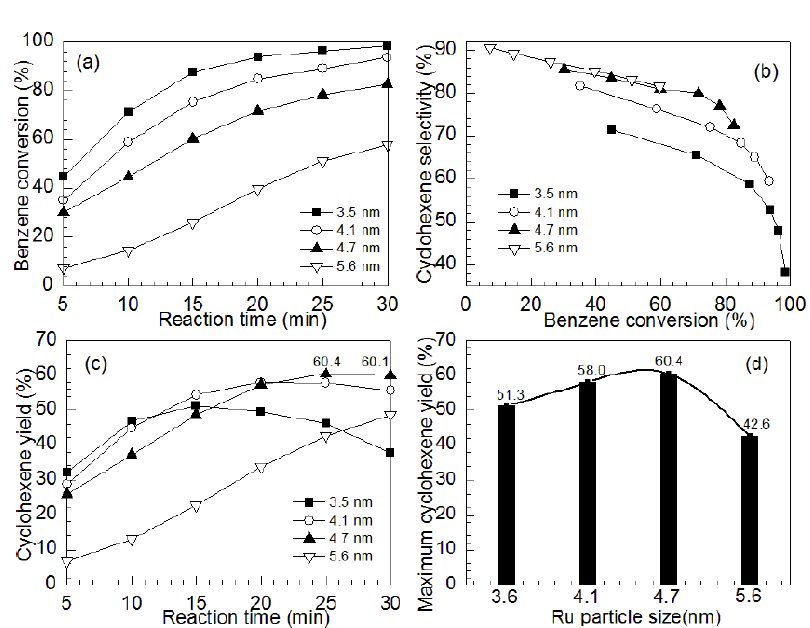
Figure 11. Benzene conversion ( a ) and cyclohexene yield ( c ) as function of time as well as cyclohexene selectivity ( b ) as function of benzene conversion and the maximum cyclohexene yield ( d ) over Ru catalyst with the different particle size ( m cat = 2.0 g, m ZnO = 0.3 g, m ZnSO4 = 50.0 g, v H2O = 280 mL, v benzene = 140 mL, T = 423 K, p H2 = 5.0 MPa).